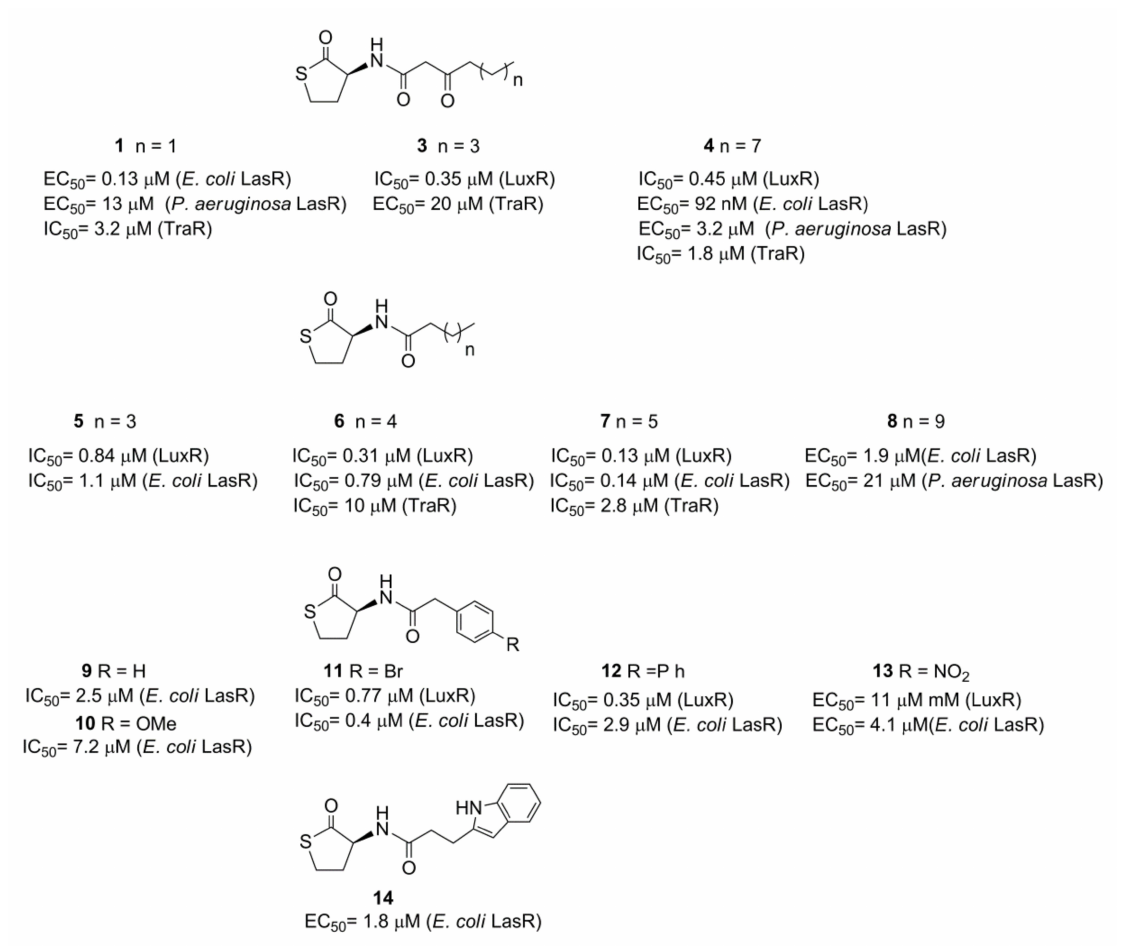
Figure 4. Thiolactone LuxR QS modulators identified by Blackwell’s group.